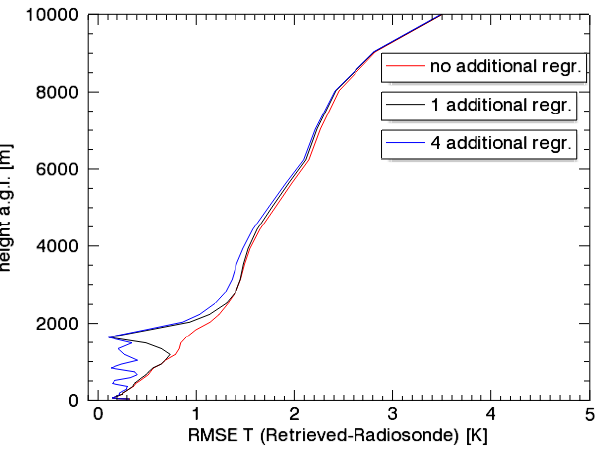
Figure 8. Effect of a specialized training considering time of year or time of day. RMSE between IMGI retrieved temperature and ra- diosonde in function of height (above the radiometer) for the full troposphere. D: daytime radiosonde (134); N: nighttime (3023); All: overall set of radiosonde (3157); SN: summer nighttime (984); S: summer (1028); WN: winter nighttime (990); W: winter (1026).